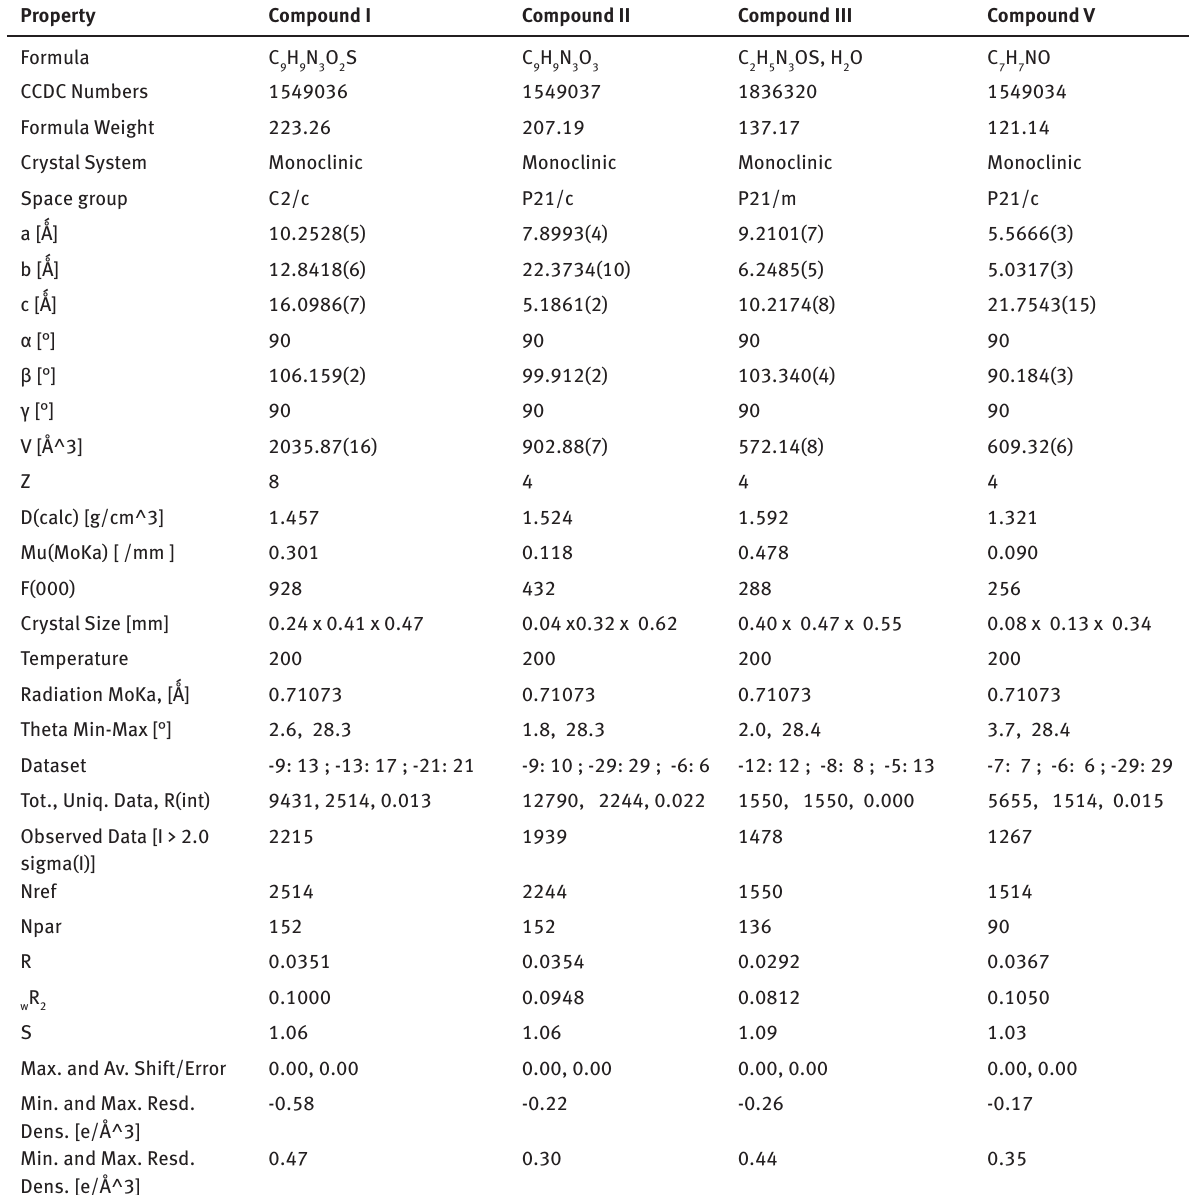
Table 1: Crystallographic data and structure refinement summary for compounds I , II , III , and V.